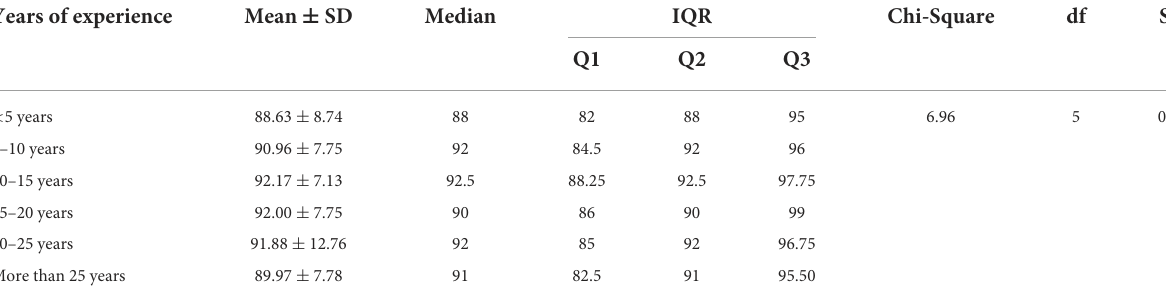
Table 2A Known group validity. Known group validity based on years of experience: Kruskal–Wallis test.